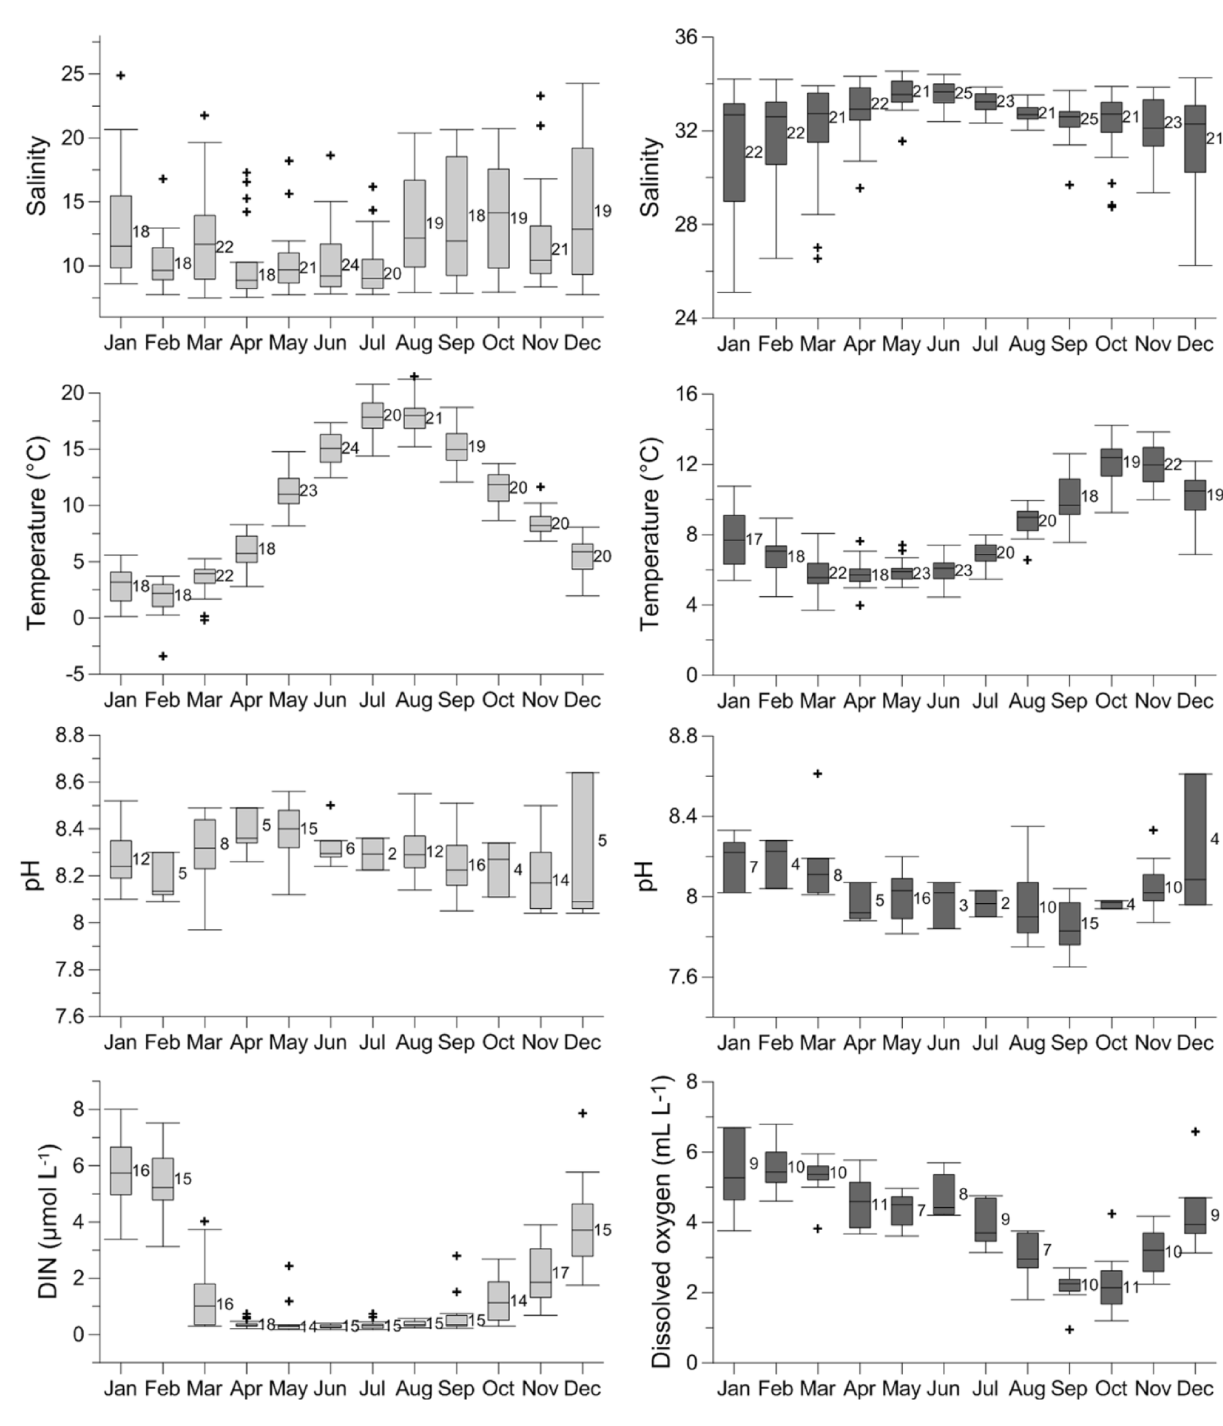
Figure 3. Seasonal variability of salinity, temperature, pH, and dissolved inorganic nitrogen (DIN) concentration at the surface water (light grey), and seasonal variability of salinity, temperature, pH, and dissolved oxygen concentration at the bottom water (40–50m) (dark grey) of the Öresund. The data were measured between 1965 and 2016 by the SMHI (Swedish Meteorological and Hydrological Institute) at station W LANDSKRONA. The number of measurements is indicated for each